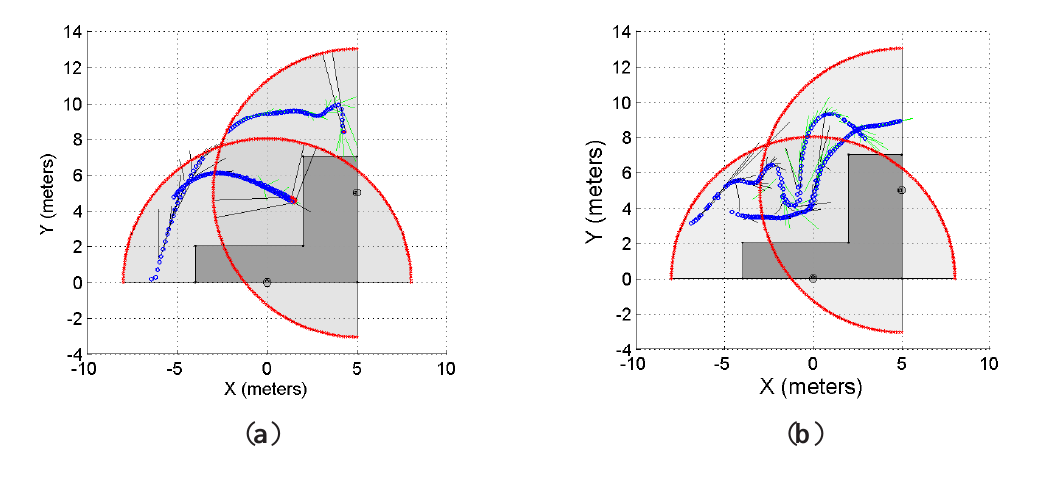
Figure 10. Multi-object prediction using a multi-laser disposition. ( a , b ) two examples of the performed experiment; ( c ) the statistical results of the